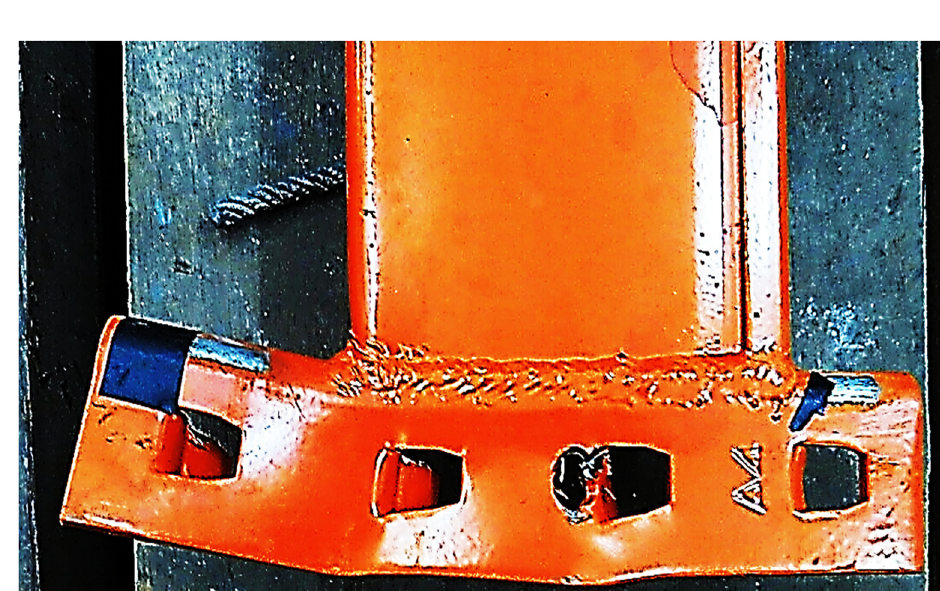
Fig 8. Deformation of the beam end